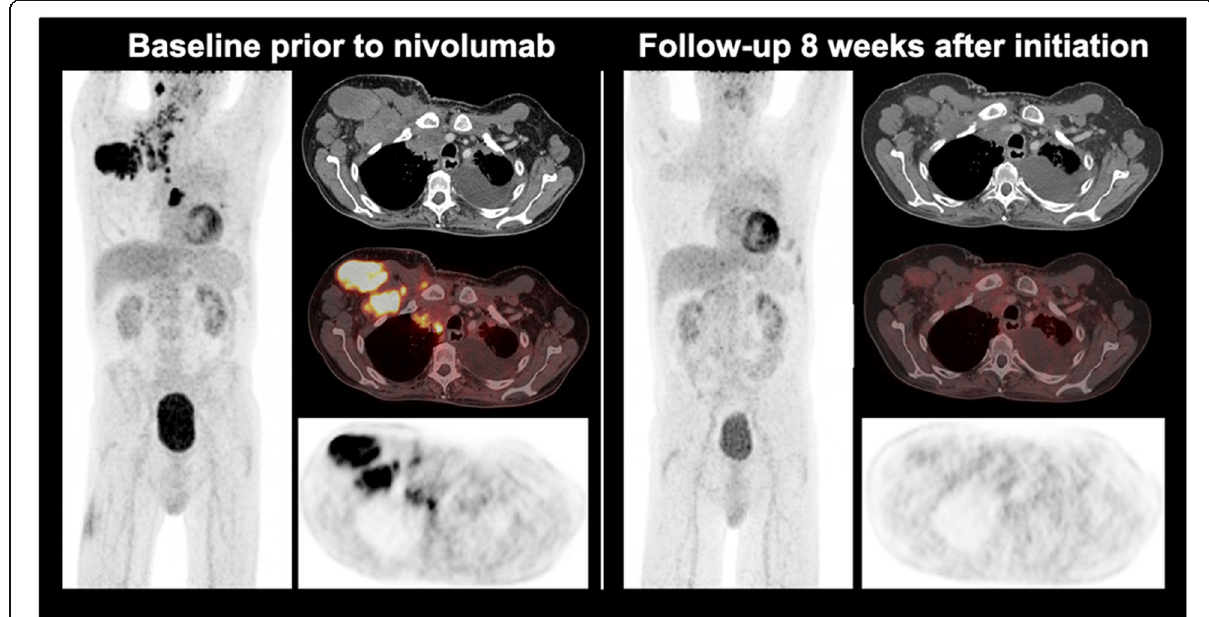
Fig. 1 A Hodgkin lymphoma patient with metabolically active tumour manifestations prior to the initiation of immunotherapy with nivolumab. A complete metabolic response already 8 weeks after immunotherapy initiation despite remaining morphological masses on CT was observed